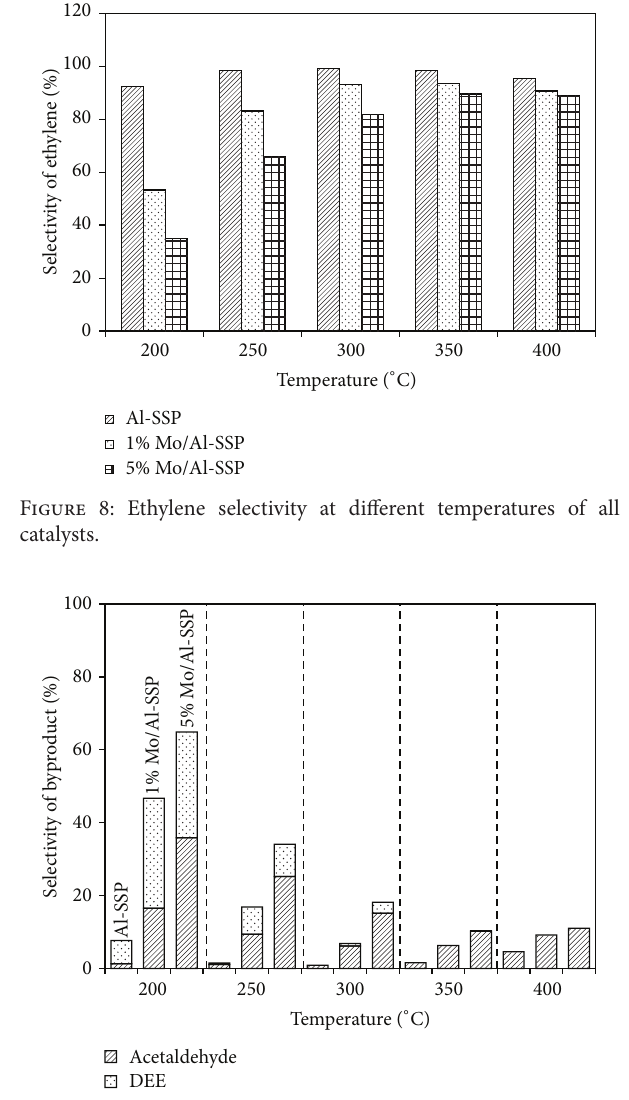
Figure 9: The selectivity of byproducts at different temperatures of all